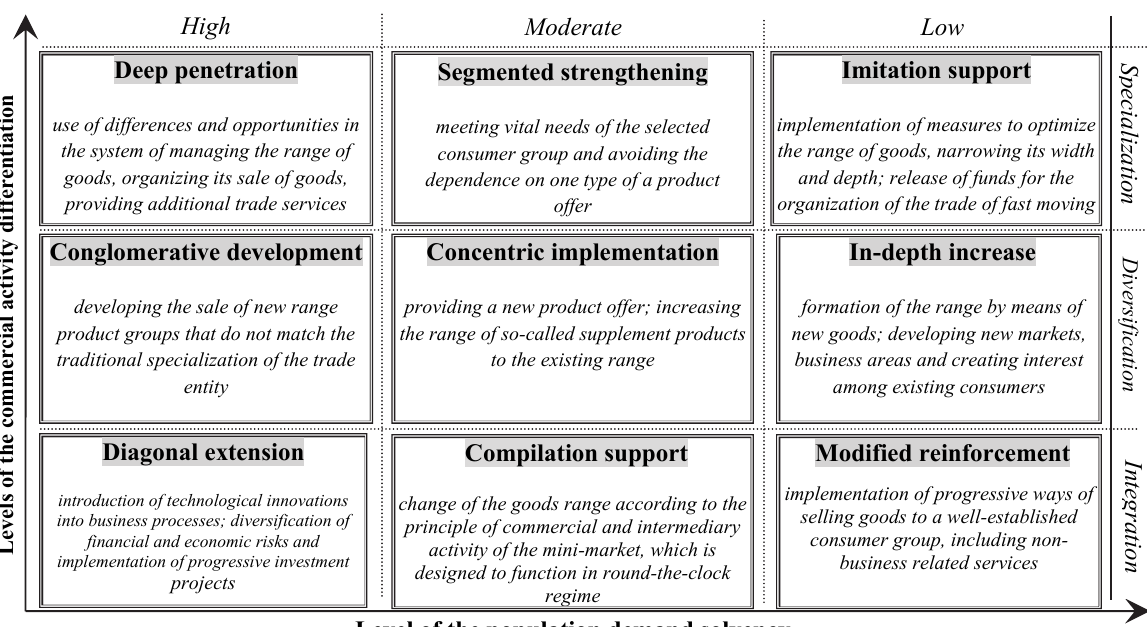
Fig. 4. Matrix of the choice of strategic decisions on the competitiveness management of the objects of socially-oriented retailers Source: own processing